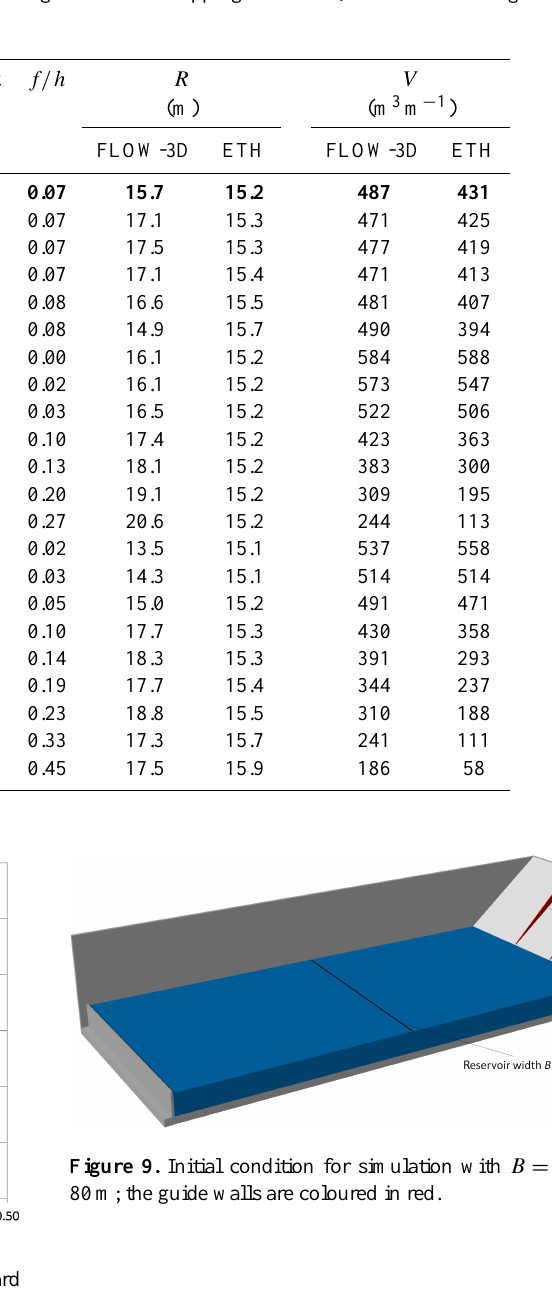
Figure 8. Overtopping volume V depending on the ratio freeboard f to still water depth h including trendlines; the results of the com- plete variation are presented in Table 2.